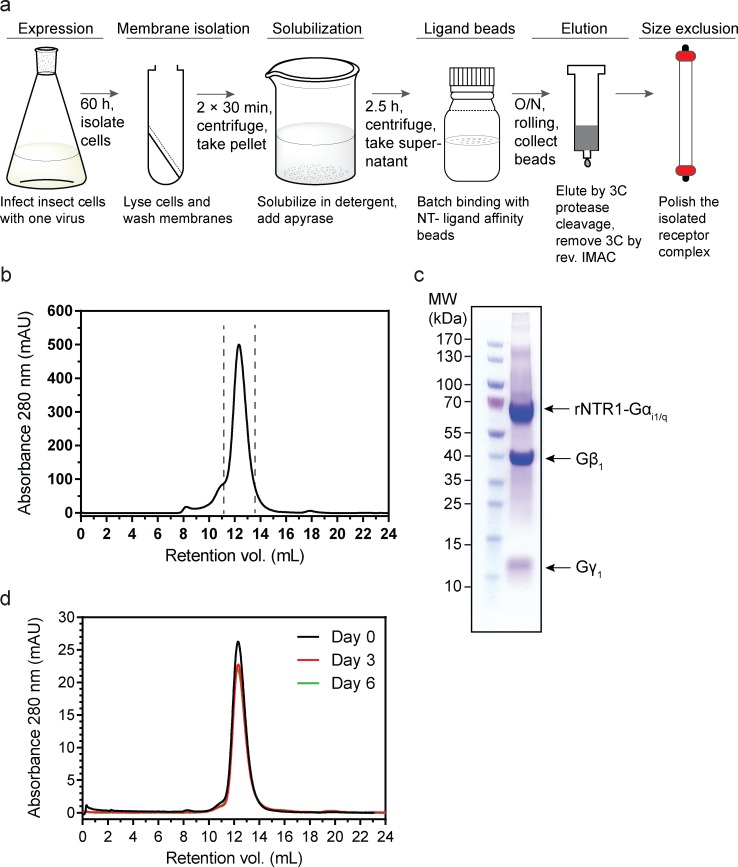
Expression and purification of rNTR1*-Gαi1/qβ1γ1 from insect cells.(a) Purification scheme for the purification of rNTR1*-Gαi1/qβ1γ1. The rNTR1-Gαi1/q fusion and β1γ1 are co-expressed in insect cells using the MultiBac system, their co-expression leads to in vivo complex formation. After isolating the membrane, solubilization was carried out in a detergent of choice, (see text for detergents used). A ligand-affinity column was used to isolate the functional complex. The protein was then eluted from the NT ligand-affinity column using 3C protease (homemade, containing His6 tag) which cleaves the intact receptor-ligand complex from the column support; the 3C protease was then removed by a reverse Ni2+-NTA affinity column. The isolated complex was further polished using size exclusion chromatography (SEC) (b) Representative elution profile of purified fusion-protein complex on a Superdex 200 10/300 GL column (GE Healthcare). (c) SDS-PAGE Coomassie-stained gel of the pooled fractions (dashed lines in b) from the gel filtration column. (d) The stability of the purified complex was monitored by analytical SEC on the same column after incubating the protein for 6 days at 4°C. The SEC profile and SDS-PAGE image (b and c, respectively) are representative of more than fifteen independent purifications. d represents protein purified using an MNG:CHS detergent mixture. The asterisk (*) denotes that a mutant of rNTR1 was used: HTGH4-ΔICL3(B) (see text).